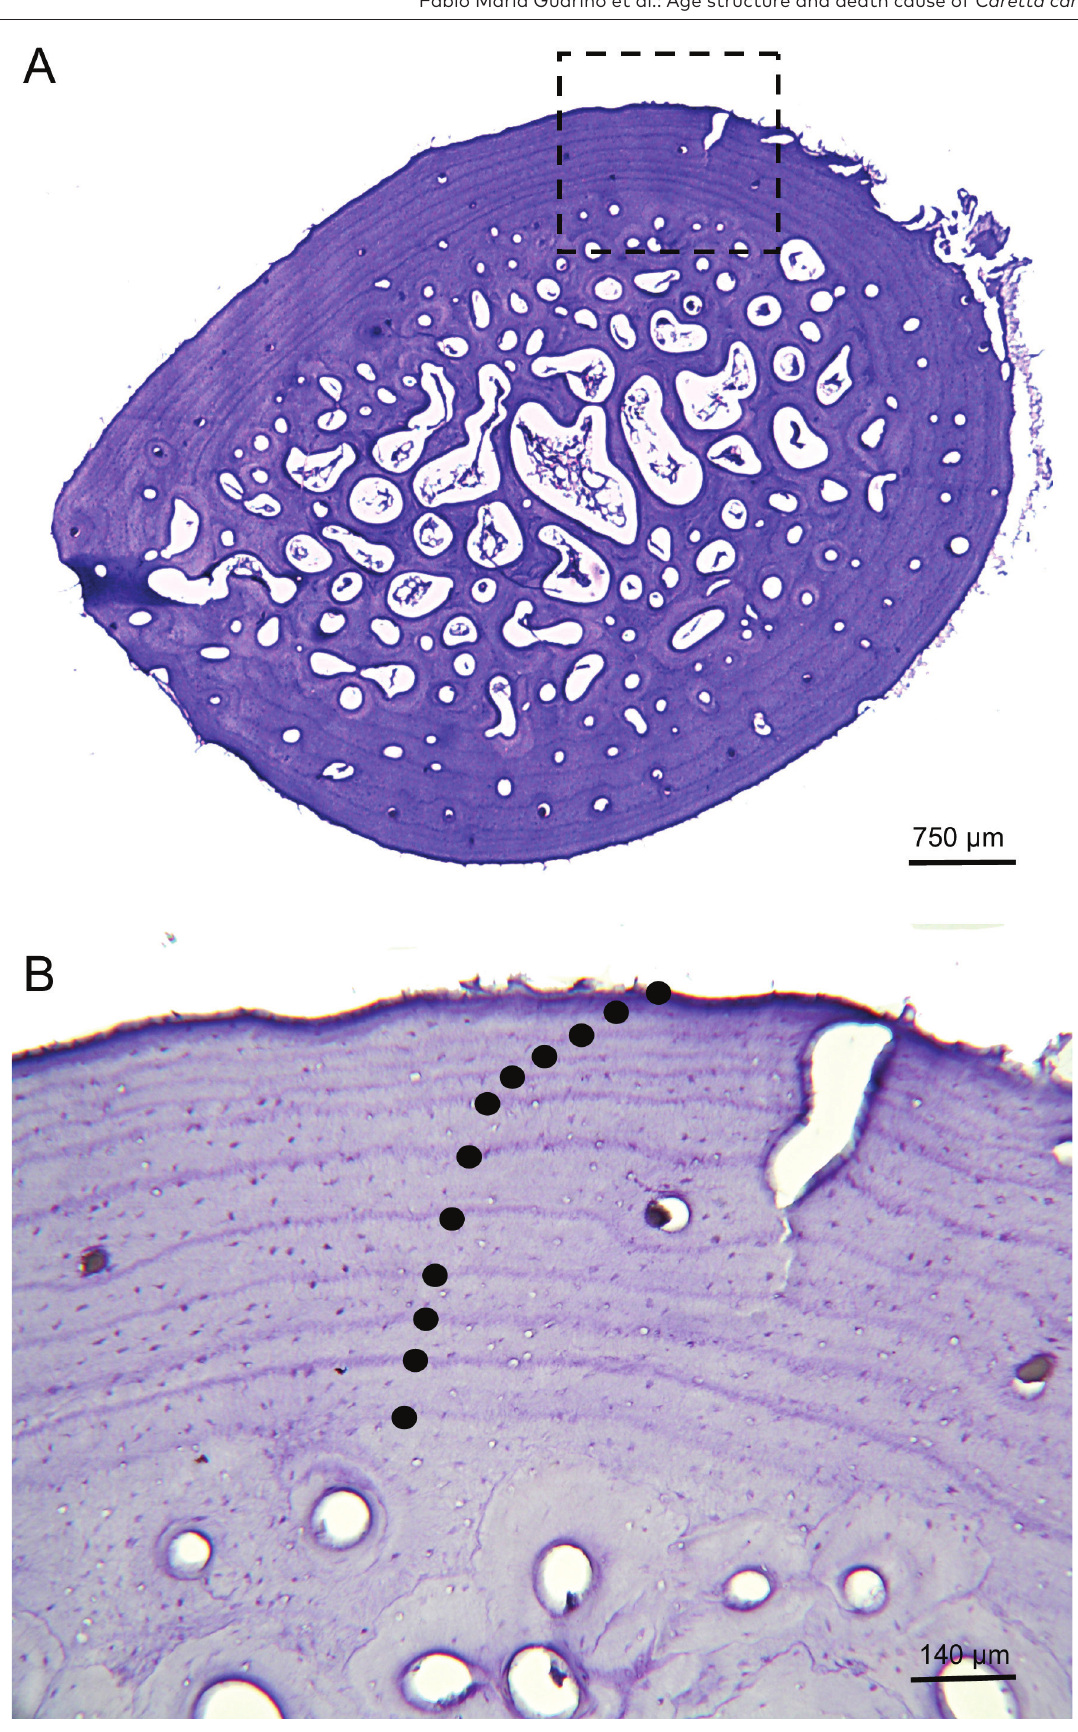
Figure 4. Representative phalanx cross-sections at the diaphyseal level of C. caretta . A) ID 123825, male, CCL = 66 cm. B) Higher magnification of the dashed square shown in Fig. A); the black circles indicate the lines of arrested growth